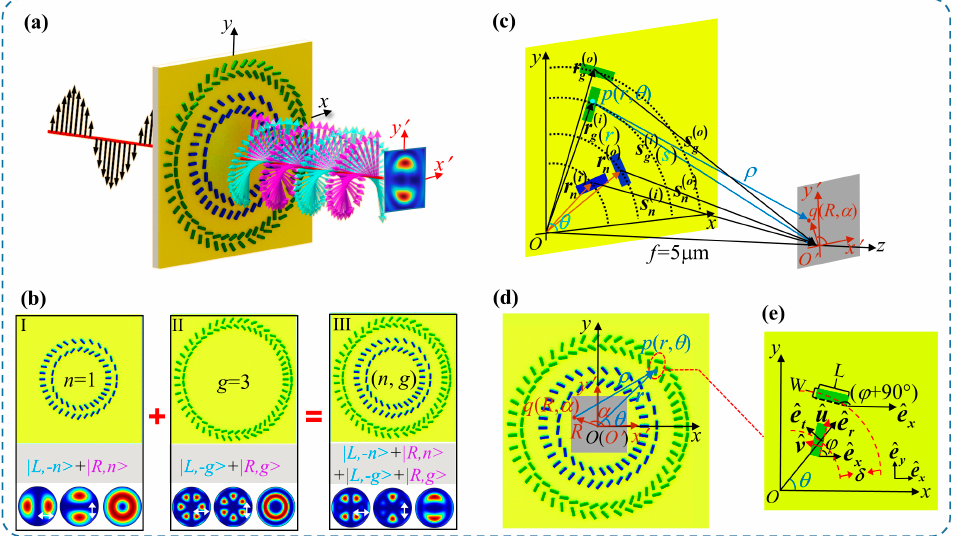
Figure 1. ( a ) Schematic for superposing the profile-tunable tightly focused VBs by metasurface. ( b ) The principle illustration for the metasurface superposes the VBs of the orders n = 1 and g = 3 with equal light intensity profiles. Panel I: metasurface of inner set slit-pairs; Panel II: metasurface of outer set slit-pairs; Panel III: metasurface consists of inner and outer sets slit-pairs. The white double arrows show the transmitting direction of the analyzing polarizer. ( c ) Geometry and coordinate relations for points on the object and observations planes. The two sets of the orthogonal slit-pairs and the rings the slits lie on are illustrated. ( d ) The overlapping view of the object plane Oxy and the observation plane O ′ x ′ y ′ . ( e ) Schematic for unit vectors of the coordinates and orientations of slits in a representative orthogonal slit-pair.